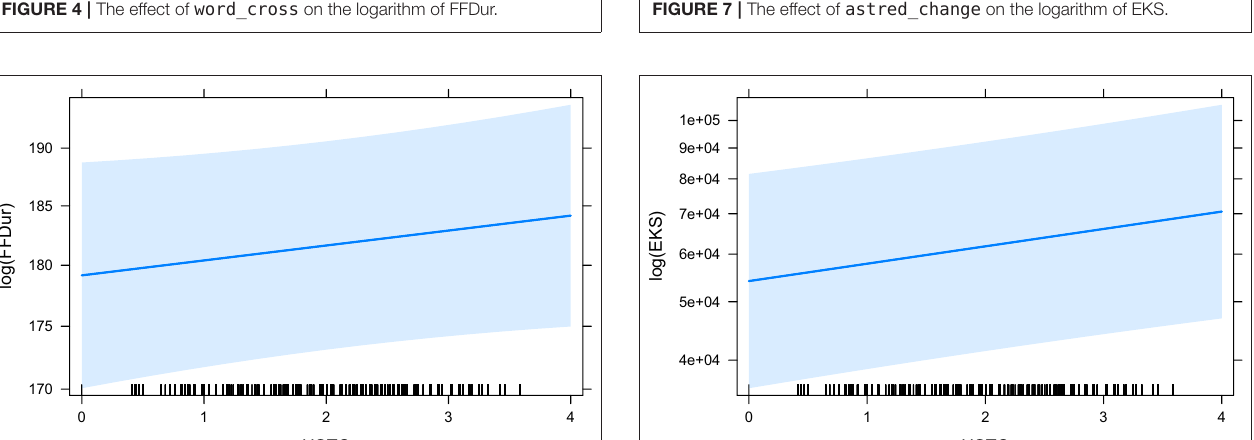
FIGURE 4 | The effect of word_cross on the logarithm of FFDur.